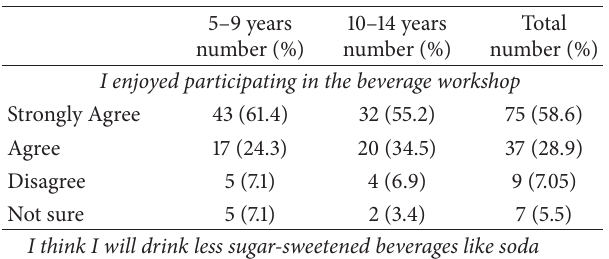
Table 2: Postprogram response: program evaluation and intention to change